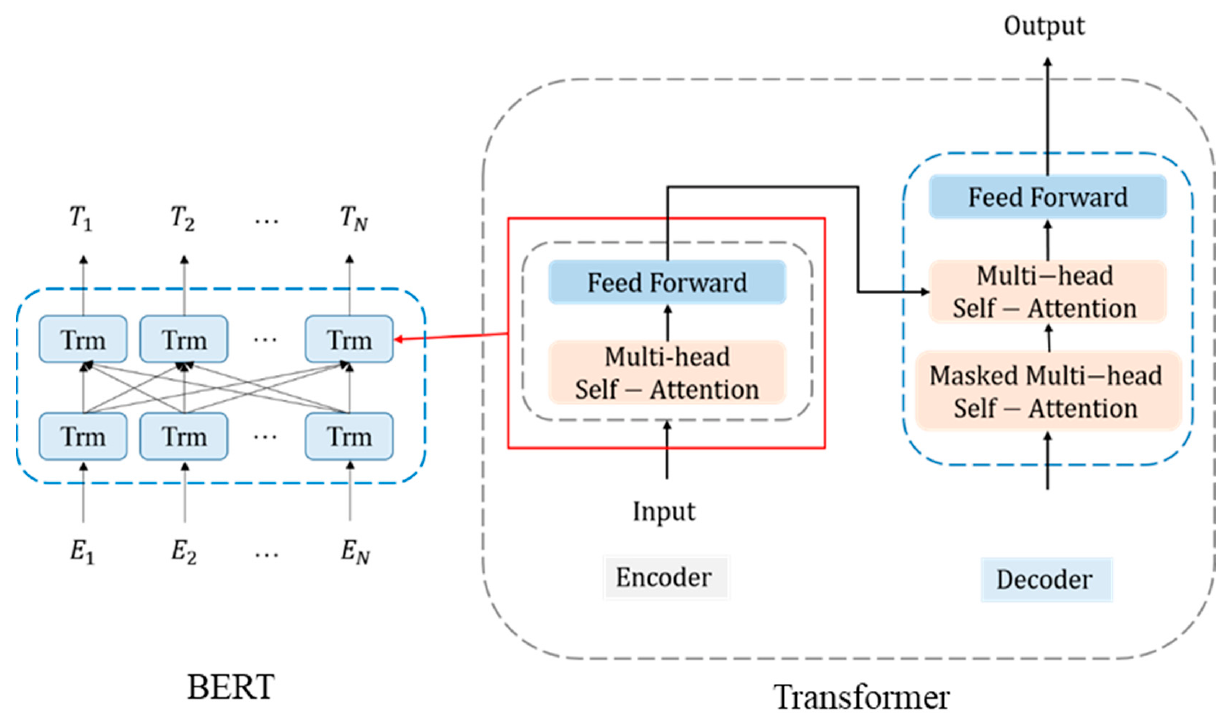
Figure 1. Architecture of the BERT model.